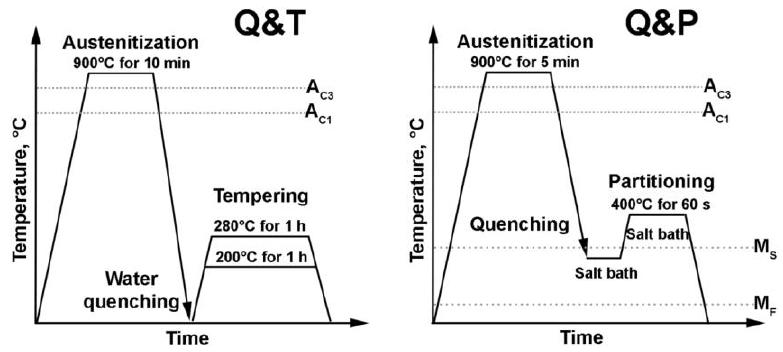
Figure 1. Schematic graphs of Q&T and Q&P